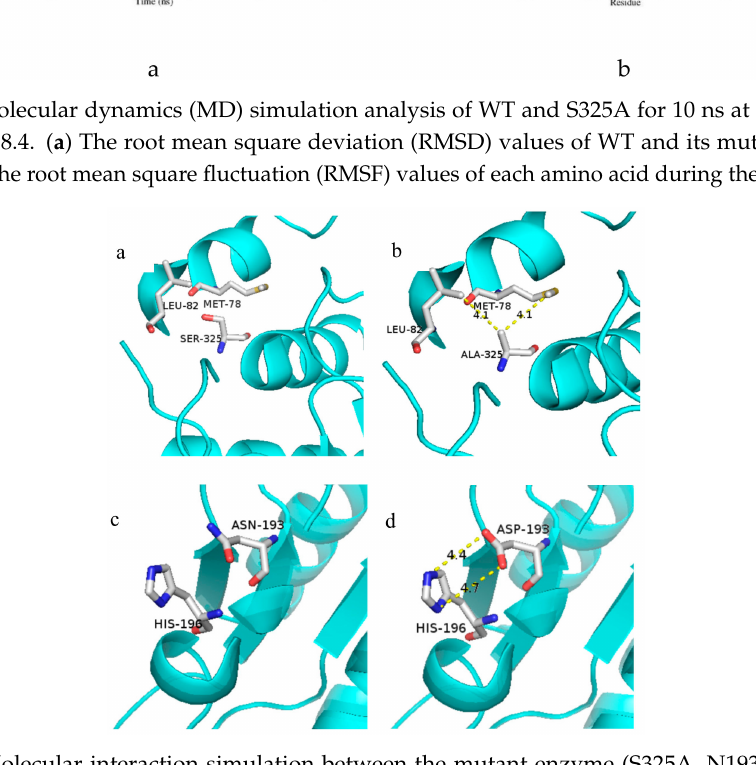
Figure 5. Molecular interaction simulation between the mutant enzyme (S325A, N193D) and WT. ( a ) The 3D structure diagram of Ser325. ( b ) In S325A, Ala325 was involved in hydrophobic interaction with the neighboring Met78 and Leu82. ( c ) The 3D structure diagram of Asn193. ( d ) In N193D, Asp193 was involved in an ionic bond with the neighboring